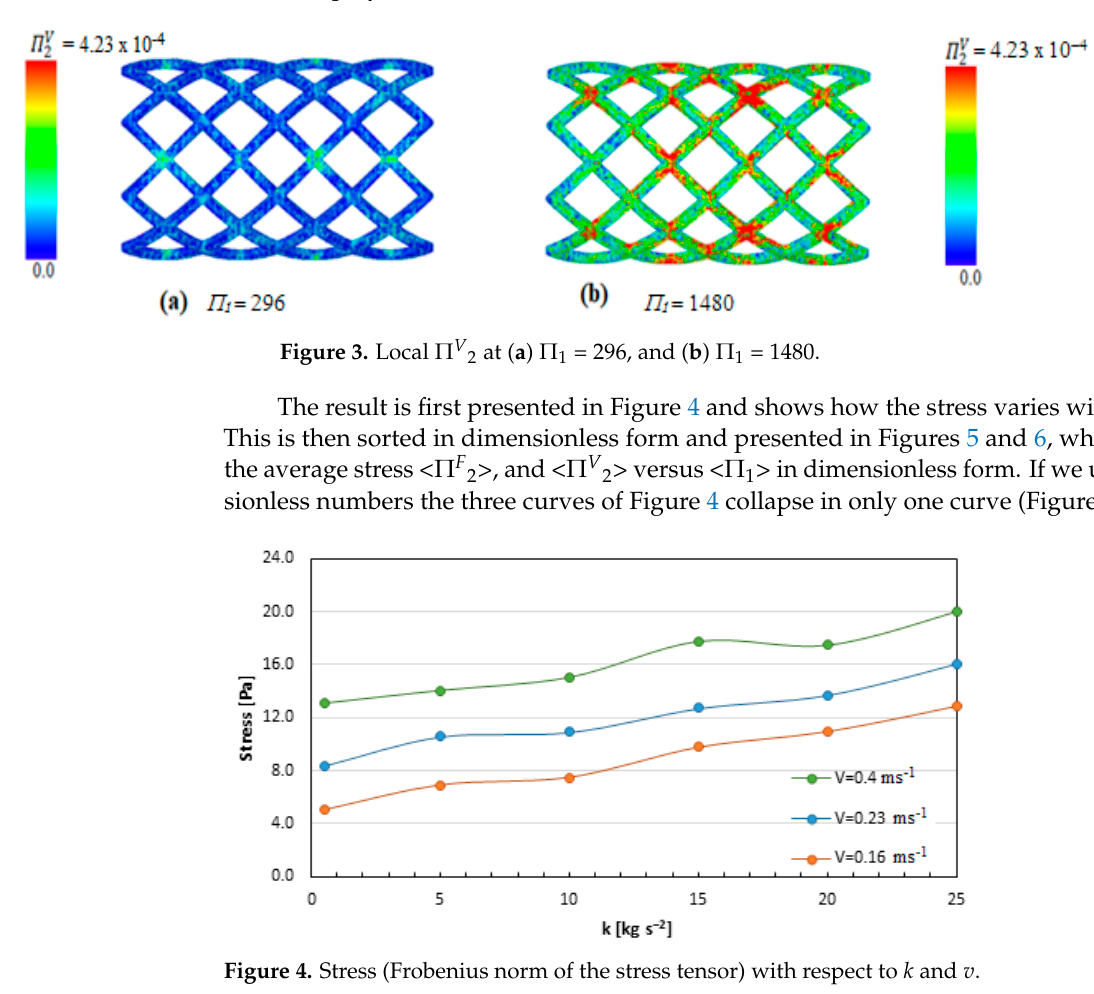
Figure 6. Relationship between average stress < Π V 2 > and < Π 1 >. The plot confirms that the stress can be effectively sorted out with two dimensionless numbers based on the Buckingham π theorem. The three curves of Figure 4 can be fit by the same function as indicated in Equation (13). This function can be approximated by the following correlation (dotted line in) < 𝛱 (cid:2870)(cid:3007) >= 0.026〈𝛱 (cid:2869) 〉 (cid:2879)(cid:2868).(cid:2875)(cid:2870)(cid:2871) .